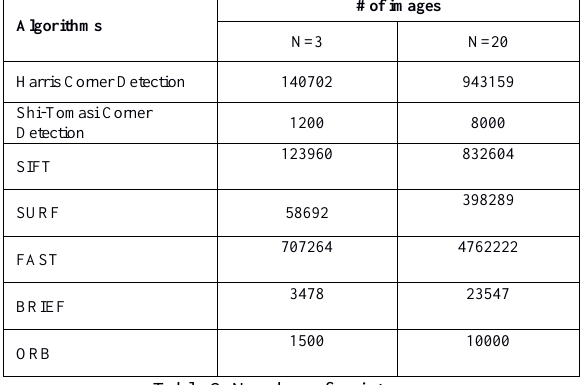
Table 2. Number of